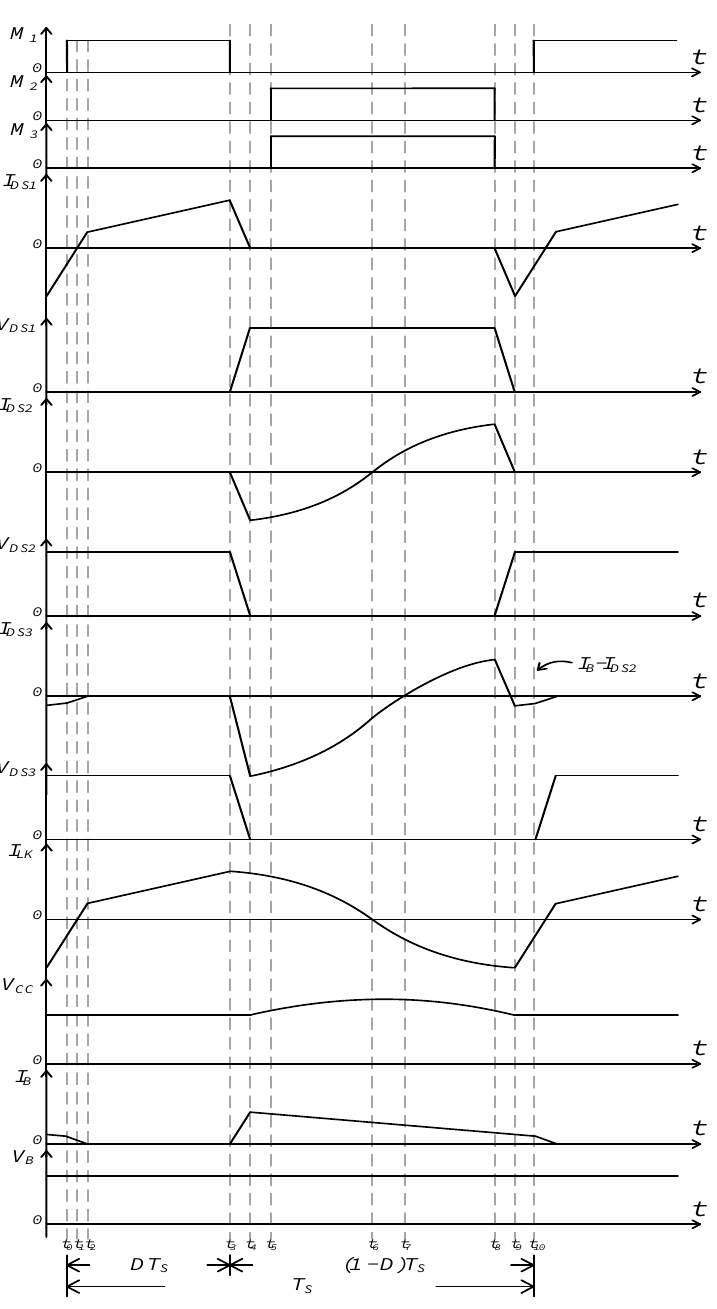
Figure 10. Conceptual waveforms of each operational mode of the proposed hybrid converter op- erated in the utility line source condition over a complete switching